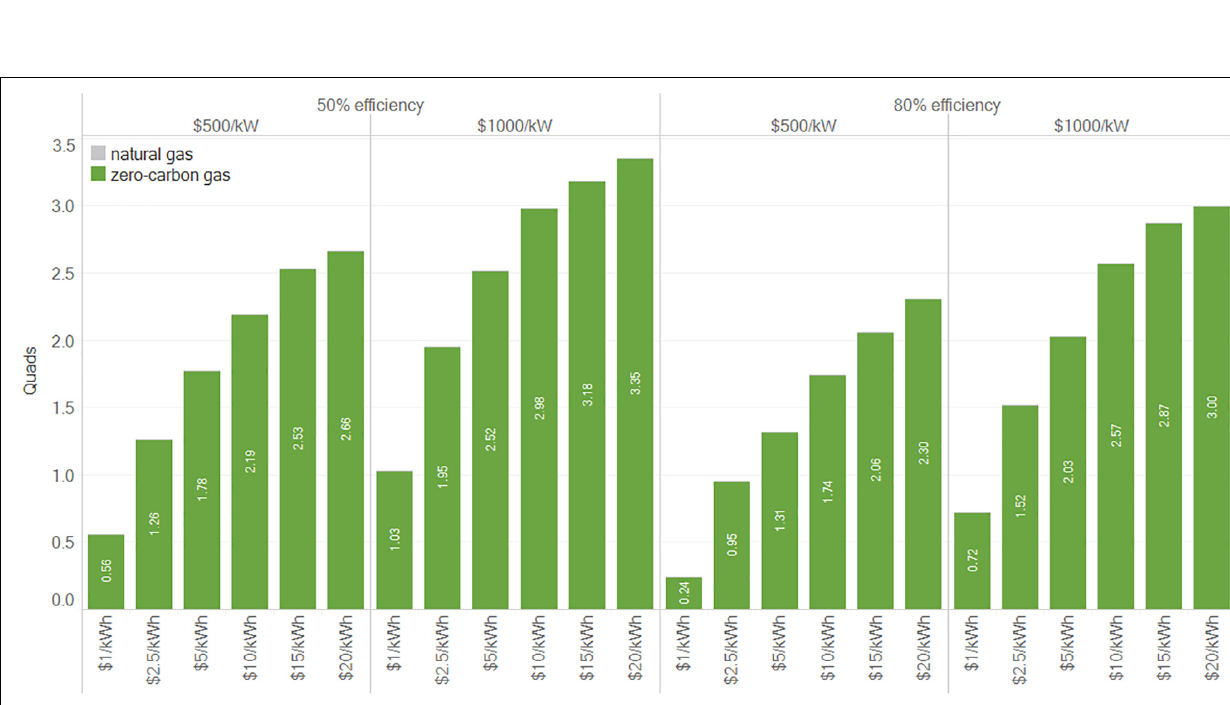
Frontiers in Energy Research |